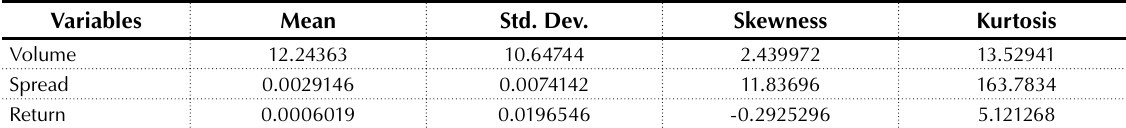
Table 3. Summary